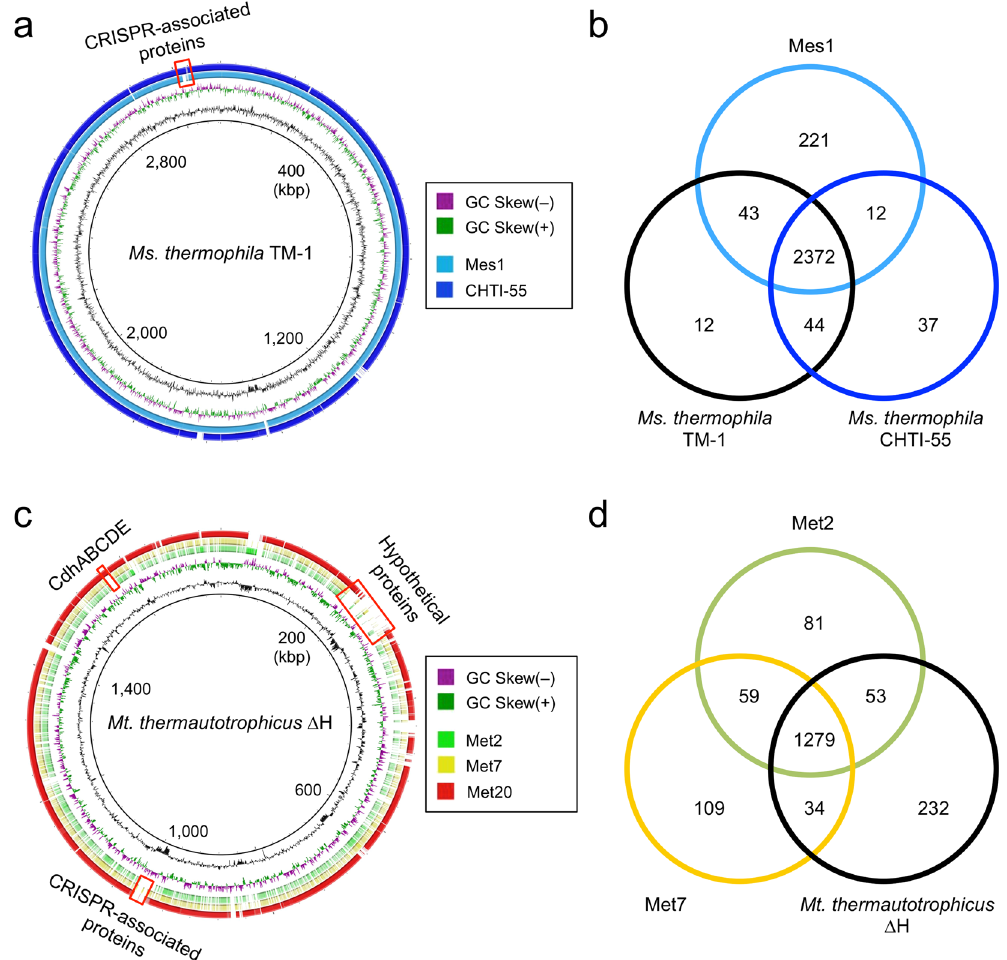
Figure 5. Comparative genomics of reconstructed Methanosarcina ( a , b ) and Methanothermobacter ( c , d ) strains. ( a , c ) Overall genome comparisons with closely related isolates using BRIG. The homology regions with the genomes of Ms . thermophila TM-1 (BLASTN e-value ≤ 1e-9) and Mt . thermautotrophicus ∆ H (e-value ≤ 1e-2) are indicated by colors. The first (inner-most) and second circles show the GC contents and GC-skew, respectively. The locations of some genes of interest are indicated by red boxes. ( b , d ) Venn diagrams showing peculiar and shared CDSs coded in Methanosarcina ( b ) and Methanothermobacter ( d ). Redundant genes were excluded from the